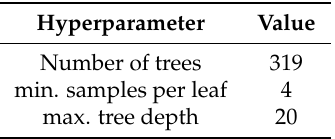
Table 3. Optimal set of hyperparameters returned by the randomized